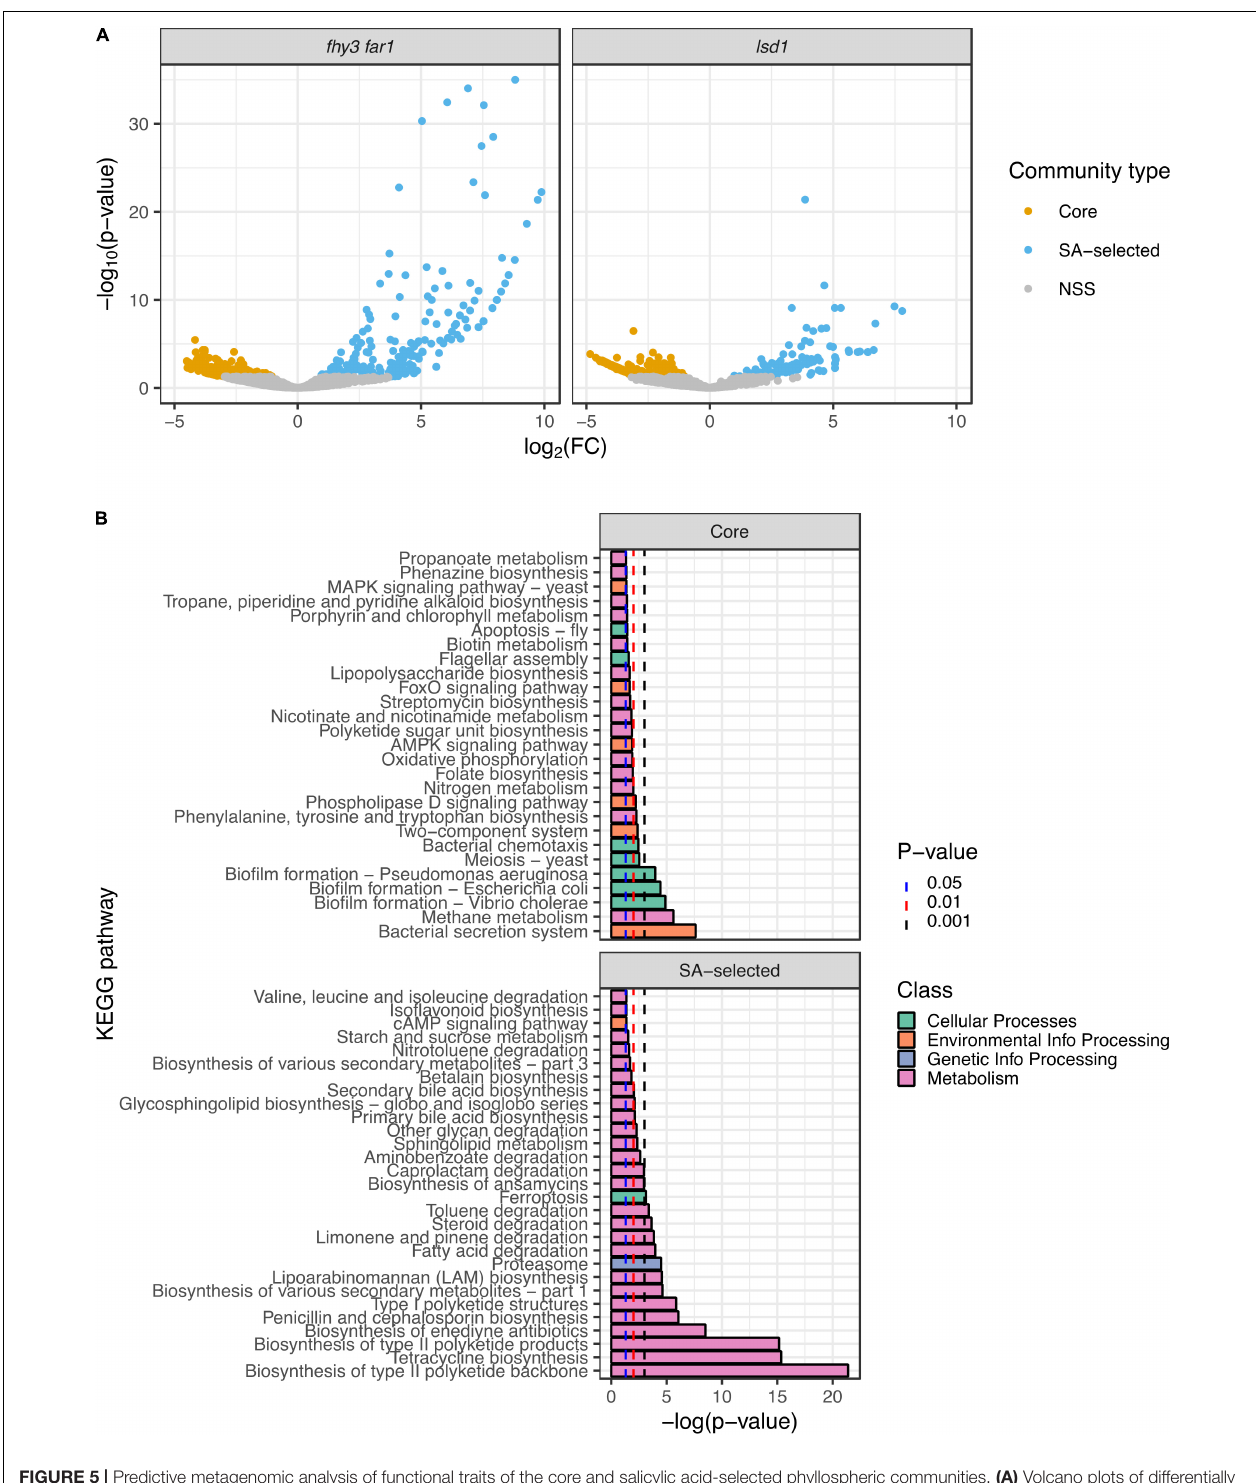
FIGURE 5 | Predictive metagenomic analysis of functional traits of the core and salicylic acid-selected phyllospheric communities. (A) Volcano plots of differentially enriched KEGG orthologs predicted in the SA-selected and core phyllospheric bacterial communities in lsd1 ( n = 3) and fhy3 far1 ( n = 2). (B) Differentially enriched KEGG pathways predicted in the SA-selected ( n = 5) and core ( n = 8) phyllospheric communities. Functional prediction was carried out using the Piphillin algorithm (Iwai et al., 2016; Narayan et al., 2020) and mapped to the KEGG database (May 2020 release) (Kanehisa and Goto, 2000; Kanehisa, 2019; Kanehisa et al., 2021). Statistical comparisons were performed using DESeq2 (Love et al., 2014). Reported p -values were values adjusted using the Benjamini-Hochberg false discovery rate (FDR) correction (Benjamini and Hochberg, 1995).